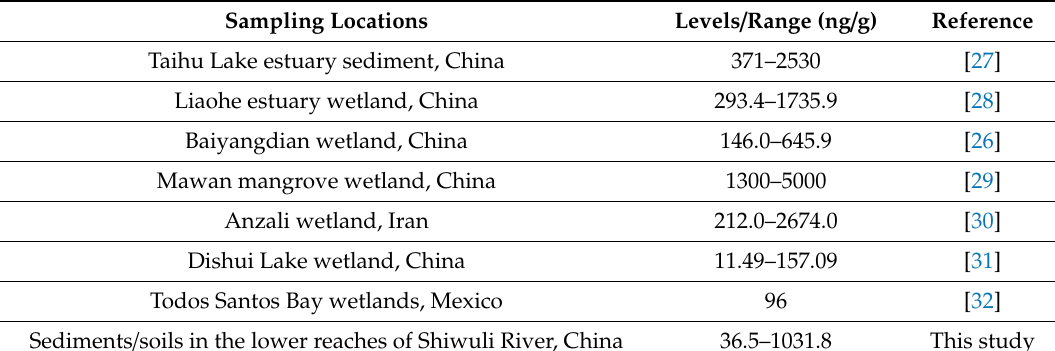
Table 2. Concentration of surface sediments / soils polycyclic aromatic hydrocarbons (PAHs) in di ff erent regions of the world (ng / g).